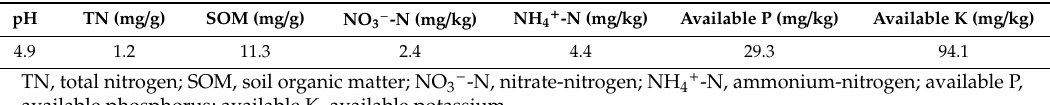
Table 1. Initial properties of soil used in the pot and field